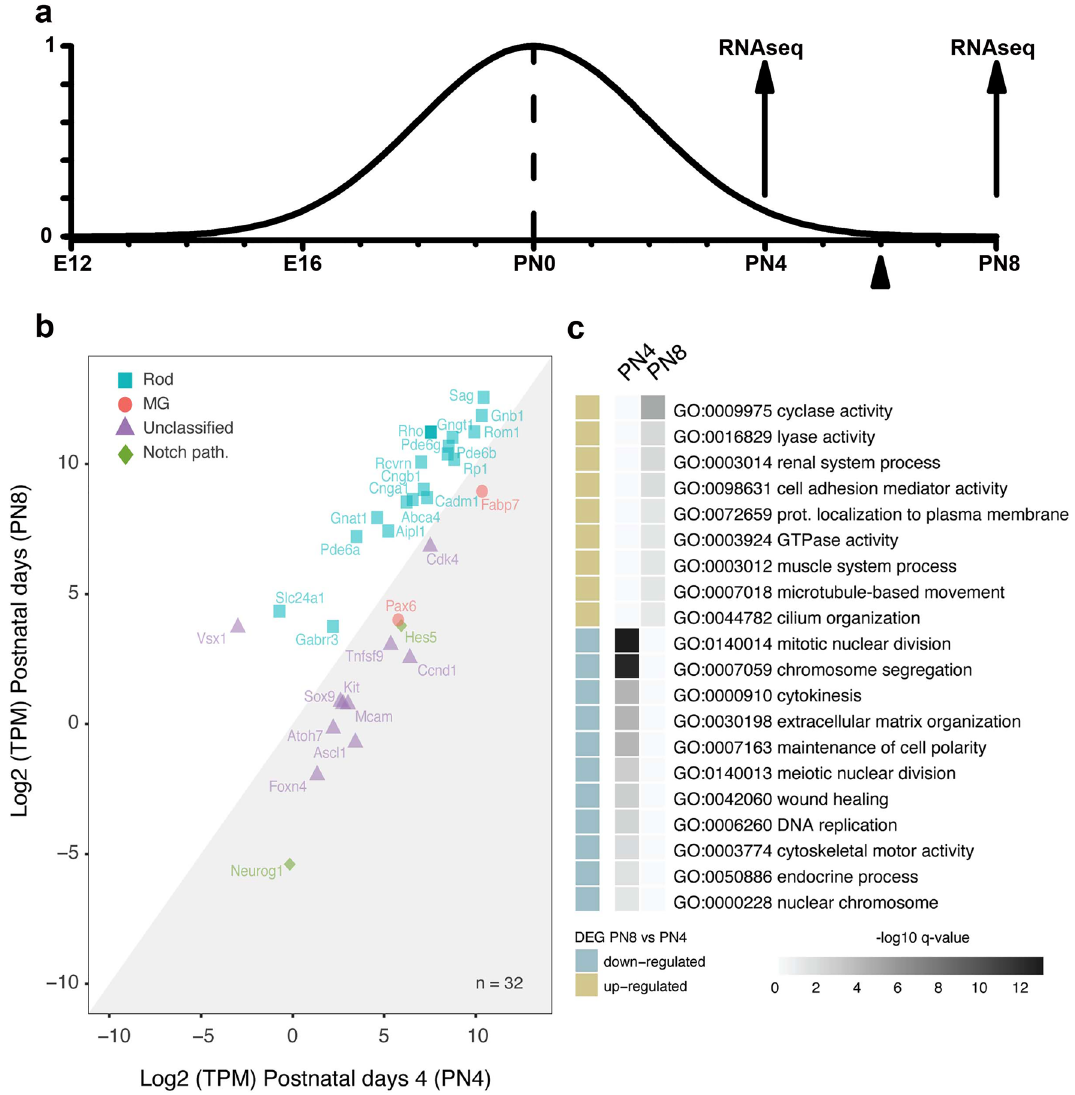
Figure 1. Transcriptome comparison of PN4 and PN8 Nrl:GFP + rod precursors. ( a ) Schematic drawing of the time course of mouse rod precursors generation. The Y-axis plots the rate of rod precursor generation in arbitrary units. Precursors appear around embryonic day 13 (E13), the rate of generation peaks around the day of birth (PN0), and the process ends around postnatal day 6 (PN6). The arrowhead indicates the time of transcriptional shift in rod precursors. Arrows at PN4 and PN8 indicate the time of GFP + rod precursors sorting for the evaluation of transcriptional changes by RNAseq analysis. ( b ) Scatter plot of log 2 Transcripts per Million reads (TPM) at PN8 vs Log 2 (TPM) at PN4. Each gene is plotted with X and Y coordinates representing normalized expression at PN4 and PN8, respectively. ( c ) Heatmap representing statistically significant GO over-represented classes associated with differentially expressed genes (fold change > |1.5| and false discovery rate =